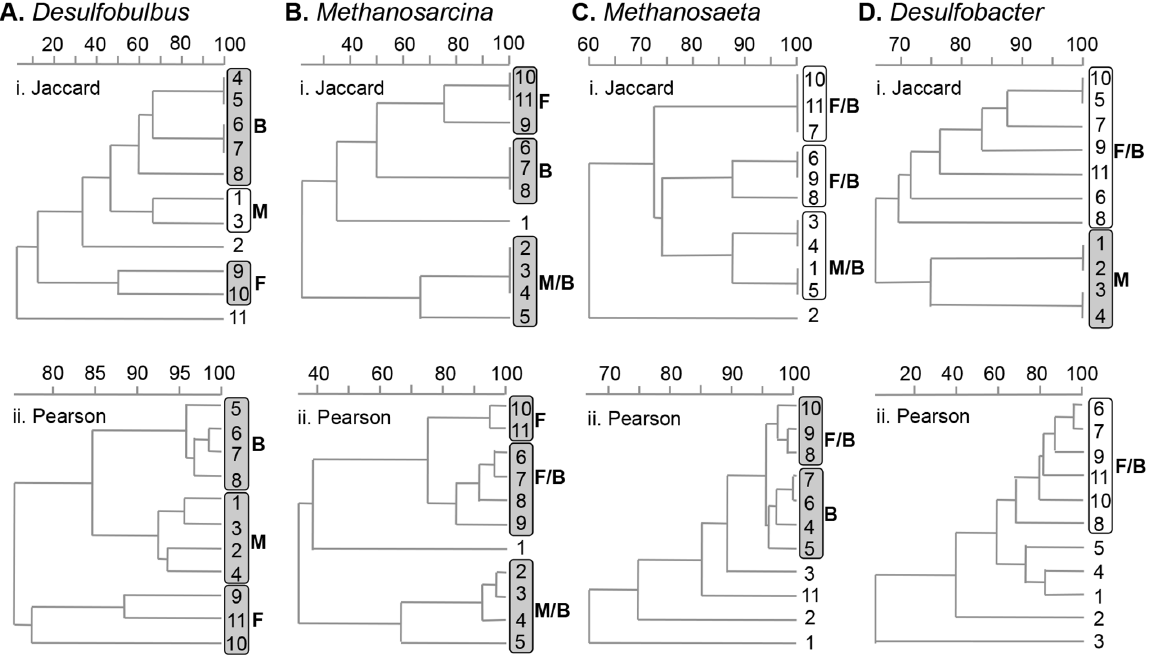
Figure 2. Cluster analyses of the DNA-DGGE profiles: i. Jaccard and ii. Pearson analyses of A. Desulfobulbus ; B. Methanosarcina ; C. Methanosaeta ; D. Desulfobacter . Marine (M), Marine/Brackish (M/B), Brackish (B), Freshwater/Brackish (F/B) and Freshwater (F) clusters are circled. Shaded clusters are geographically continuous, unshaded clusters are not.